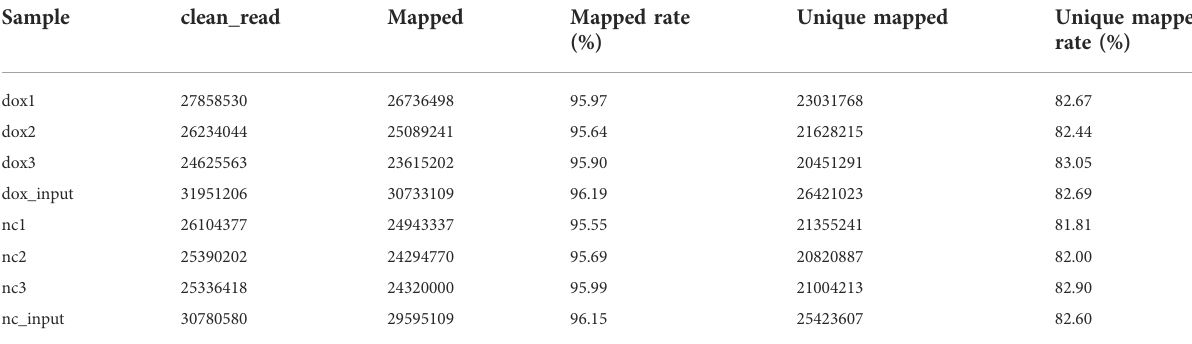
TABLE 2 Comparison results of sequencing